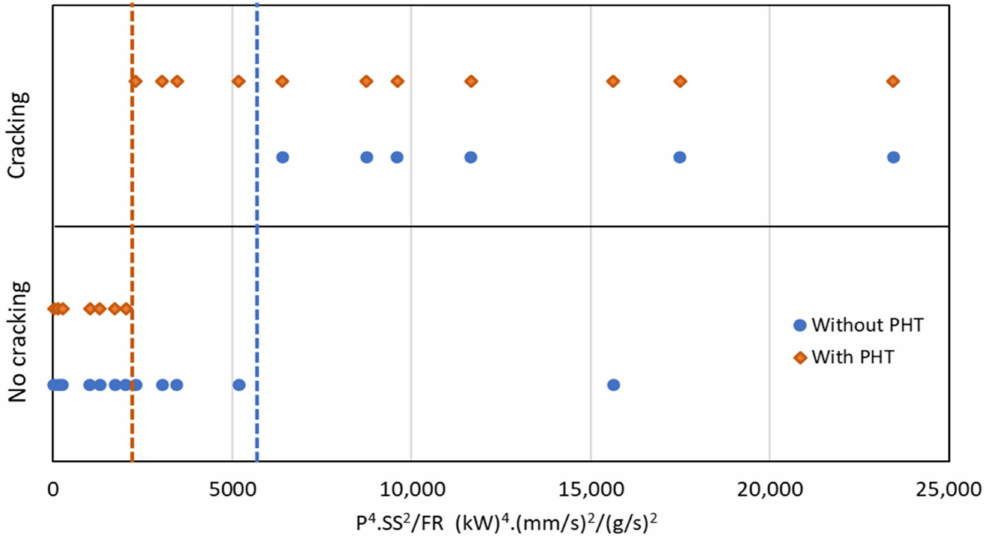
Figure 11. Relationship between the processing parameters expressed by the P 4 · SS 2 /FR complex parameter in the formation of